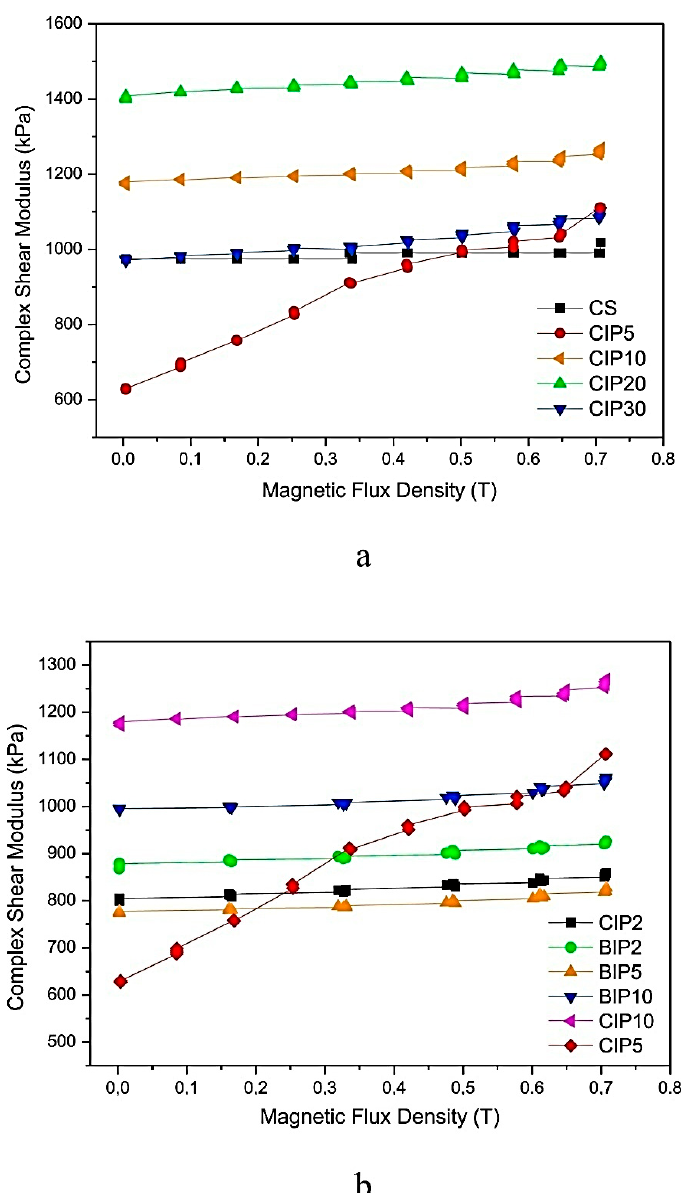
Figure 13. The plot of complex shear modulus vs. magnetic flux density of EPDM-based MREs with warious concentration of CIPs and BIPs ( a ) 5–30 phr of CIPs, ( b ) 2–10 phr of CIPs and 2–10 phr of BIPs [24] (reprinted with permission from Elsevier TM ).